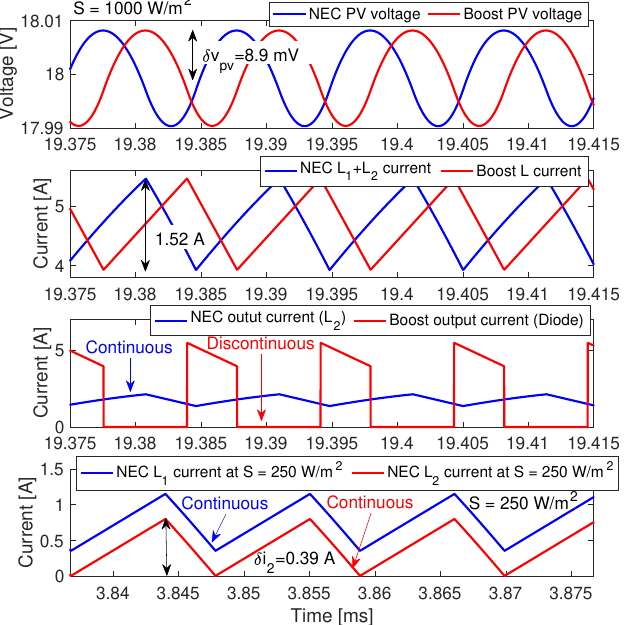
Figure 15. Steady-state operation of the PV system and comparison with the classical boost